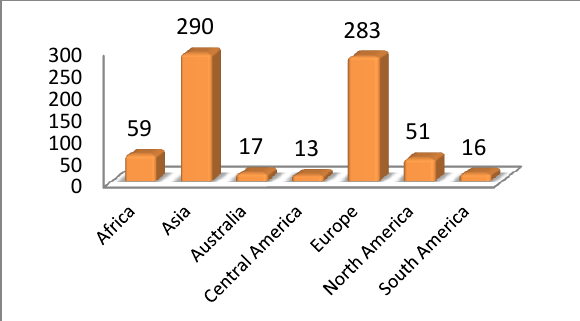
Figure 5. Regional distribution of the current members of the ISPRS Student